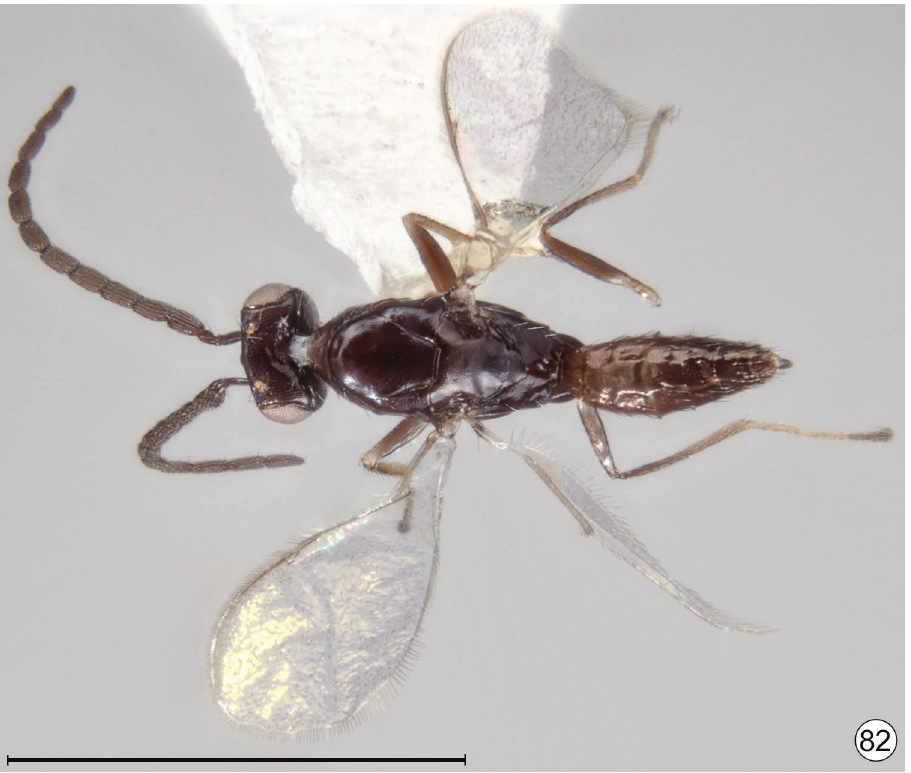
Figure 82. Neotriadomerus darlingi , paratype male, habitus dorsal (35 km N. Renmark, 263 m, 15.ii–15. iv.2000). Scale bar = 1000